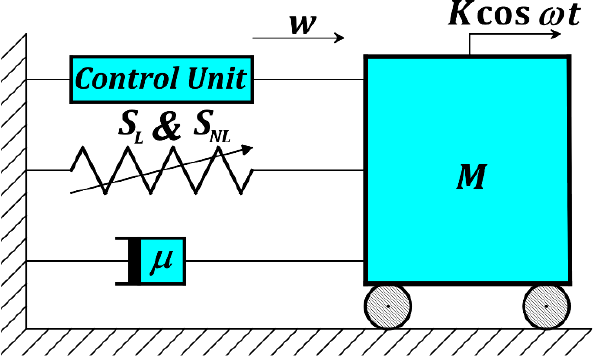
Figure 1. Mass-damper-spring model attached with a control unit.